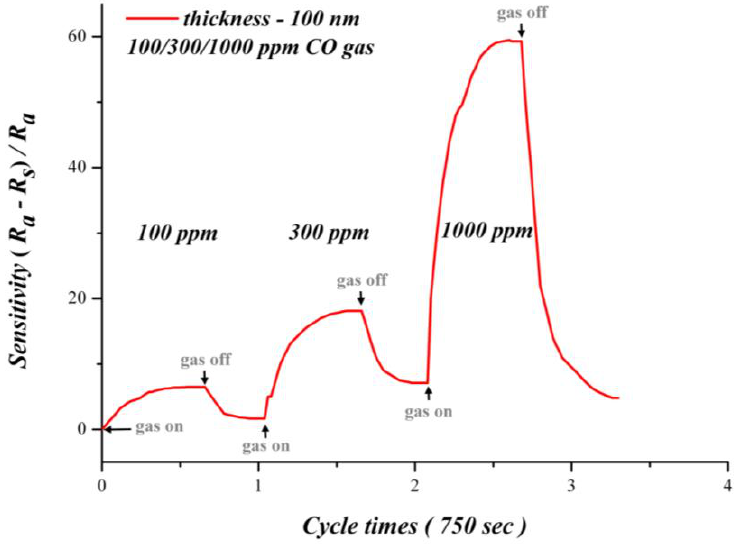
Figure 13. Testing for various CO concentrations (270 °C).